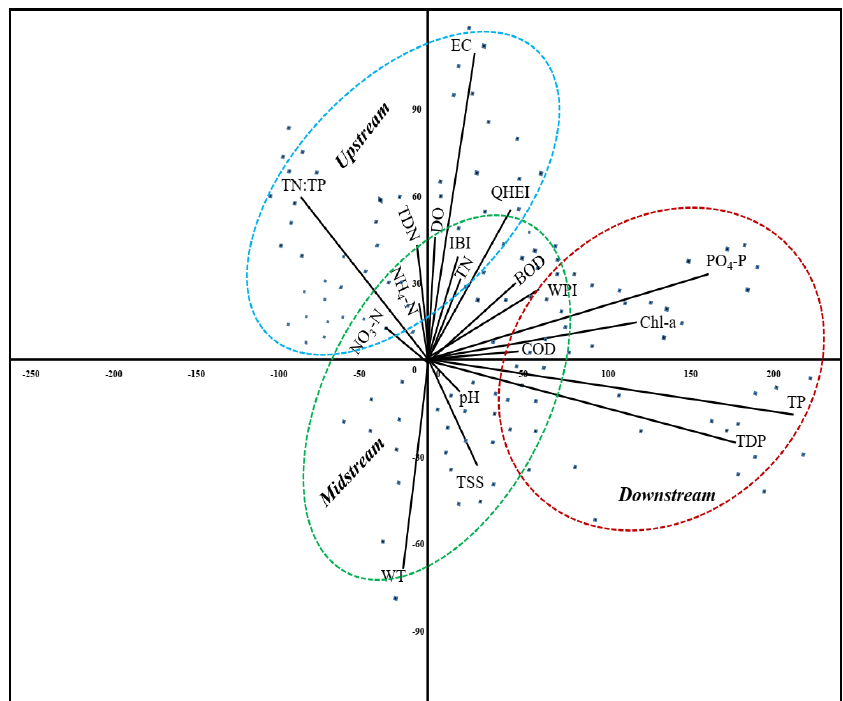
Figure 8. PCA plot showing the settlement of water quality parameters as well as IBI, QHEI and WPI in the three main compartments of Gap Stream i.e., upstream, midstream and downstream during 2007–2016. (WT = Water temperature, EC = Electrical conductivity, DO = Dissolved oxygen, TDN = Total dissolved nitrogen, NH 4 -N = Ammonia nitrogen, NO 3 -N = Nitrate nitrogen, TN = Total nitrogen, TP = Total phosphorus, TDP = Total dissolved phosphorus, PO 4 -P =Phosphate phosphorus, BOD = Biological oxygen demand, COD = Chemical oxygen demand, SS = Suspended solids, CHL-a = Chlorophyll-a, WPI = Water pollution index, IBI = Index of biotic integrity, QHEI = Qualitative habitat evaluation